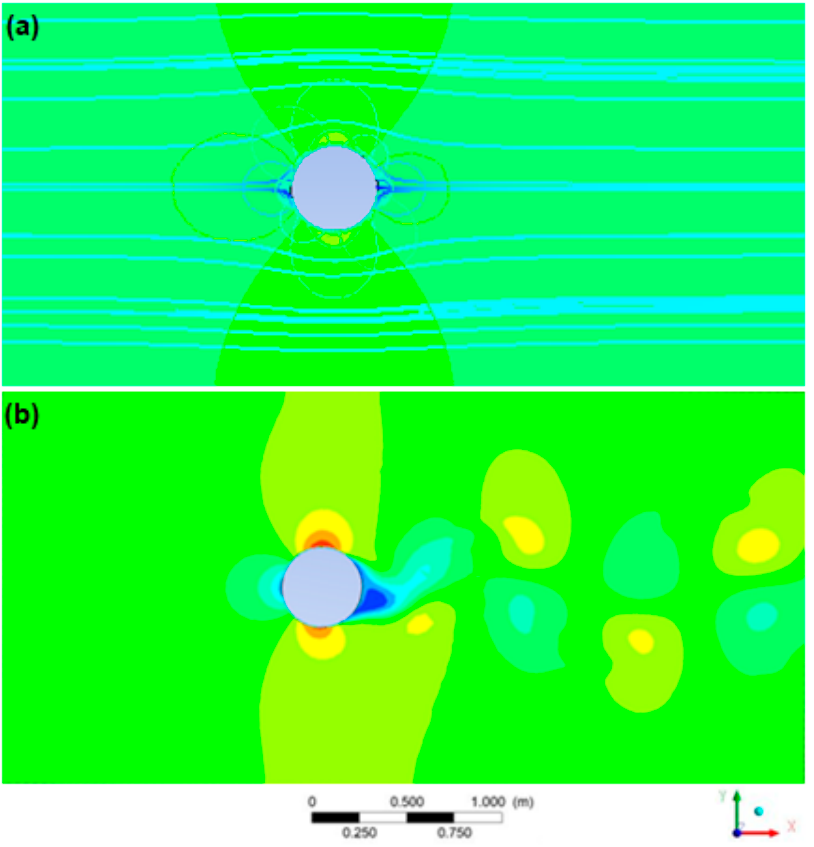
Figure 10. Velocity u Contour profile for Vortex effect around the CALM Buoy for ( a ) 0.45 m/s flow velocity with streamlines and ( b ) 1.5 m/s flow velocity without streamlines, in ANSYS Fluent.